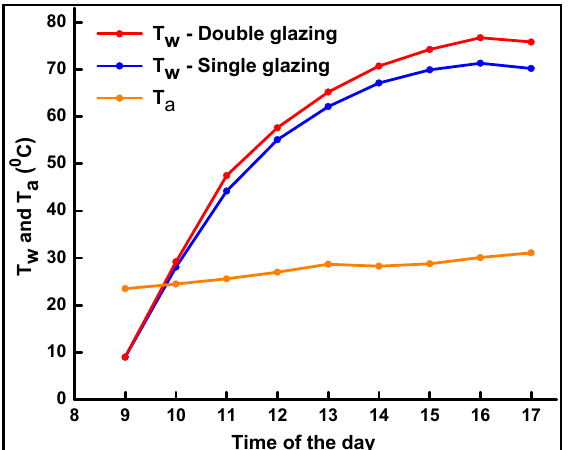
Figure 6. Water and ambient temperatures (T w and T a ) vs. time of day for two plain Al containers in single- and double-glazed solar heating systems, Sunny Day, Date: 26 September 2021, Amman, Jordan.